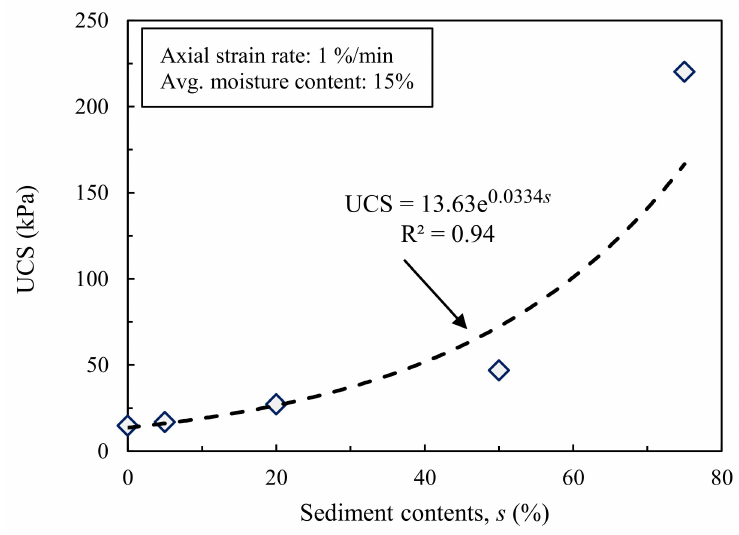
Figure 10. Effect of sediment content on unconfined compressive strength of specimens.